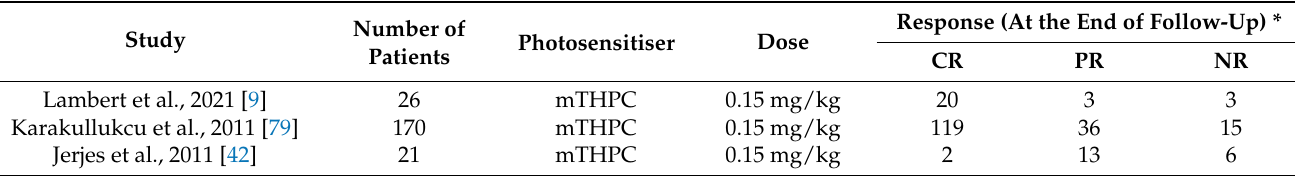
Table 3. Summary of recent studies investigating the efficacy of PDT in the treatment of oropharyngeal carcinomas. Number of Study Photosensitiser Dose Patients